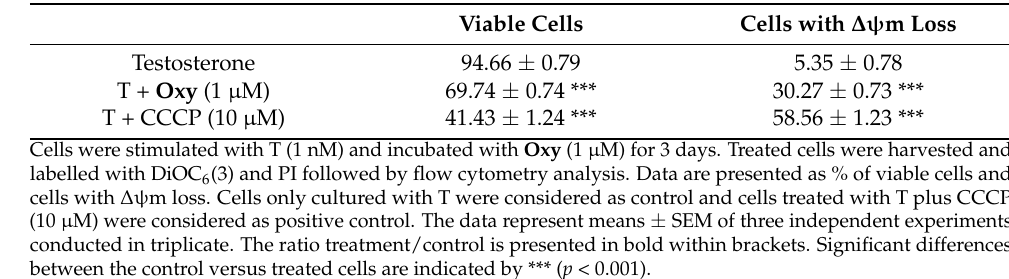
Table 2. Effects of Oxy on mitochondrial transmembrane potential ( ∆ ψ m) in MCF-7aro cells.